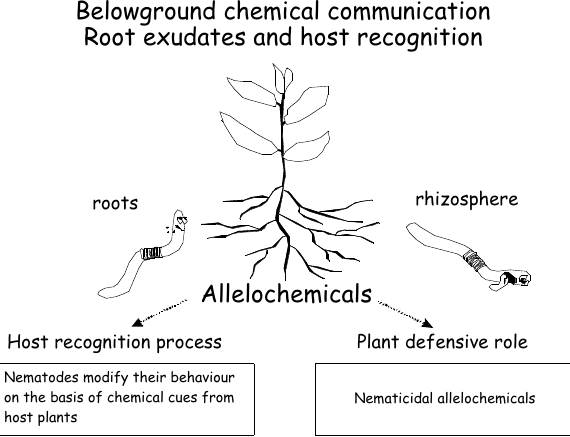
Fig. 1. – Allelochemicals can be found in parts of the plant and can also be secreted as root exudates or released as volatile com- pounds. They mediate chemical interactions between two plants as well as plant-pathogen chemical communication. Attraction, pene- tration and feeding behaviour of plant parasitic nematodes involve molecular communication between the nematode and respective plants. Root exudates can induce attraction, repellence, inhibition and hatching